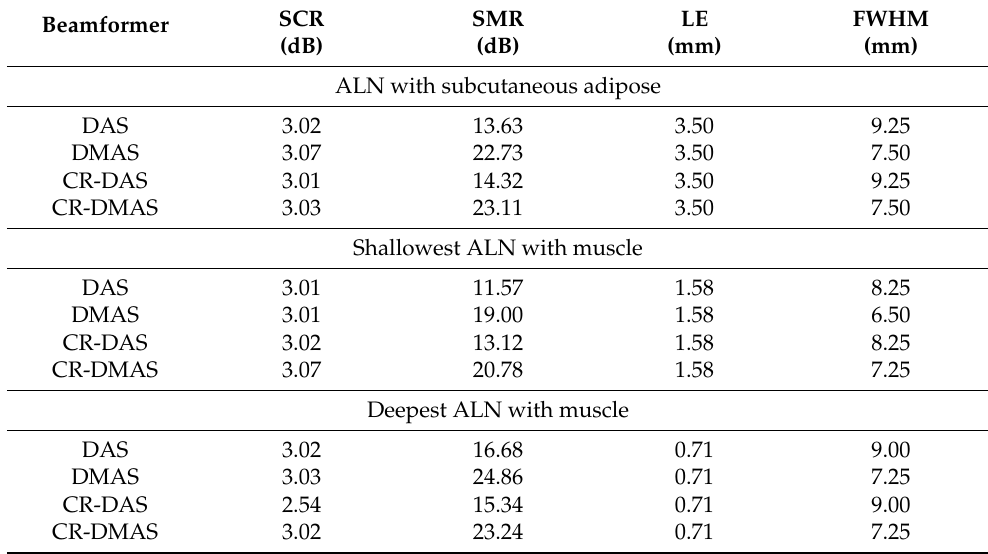
Table 3. Performance metrics of all the beamformers using Bond’s skin artifact removal algorithm for one ALN with new layers of subcutaneous adipose tissue or